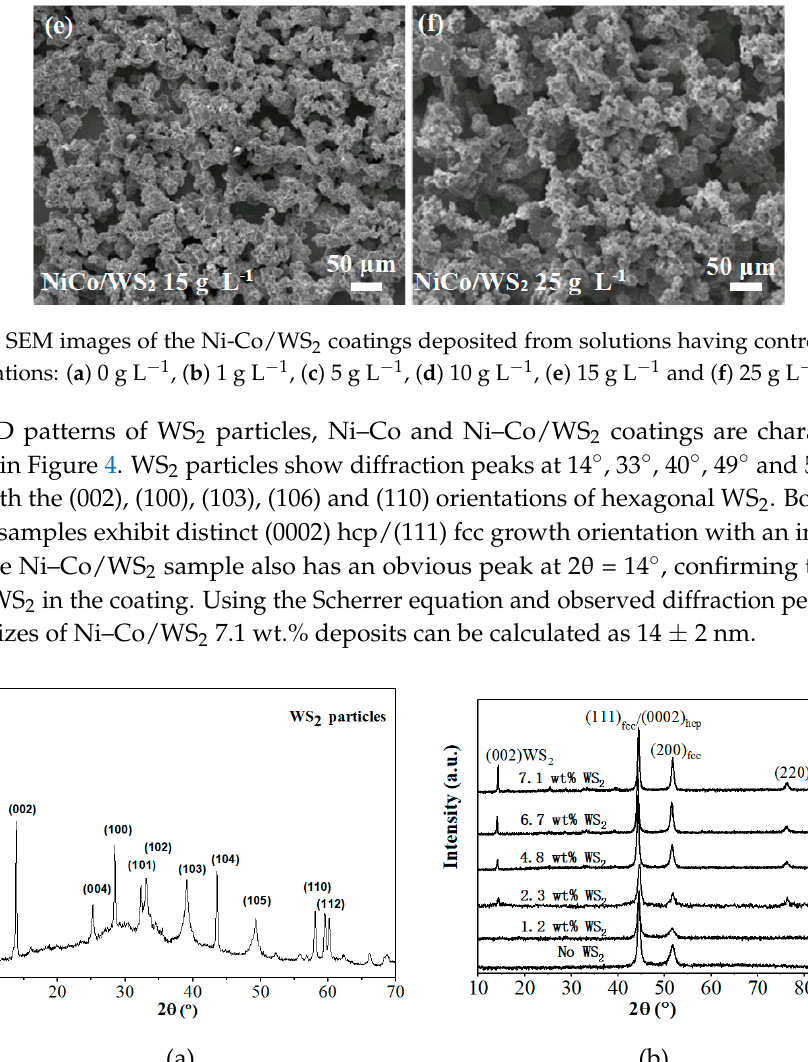
Figure 4. XRD patterns of ( a ) WS 2 particles and ( b ) Ni-Co/WS 2 samples with different WS 2 contents.